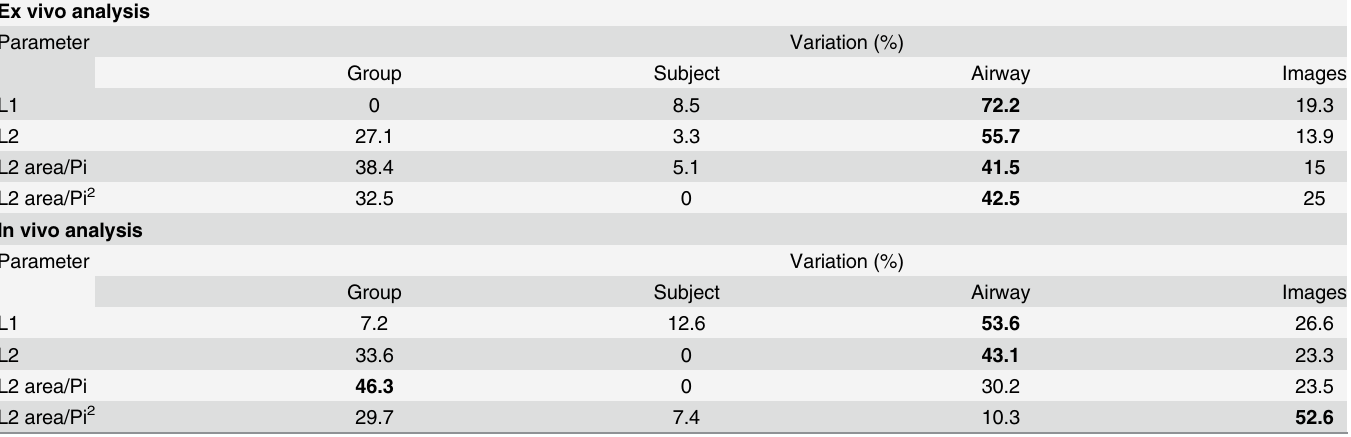
Table 4. Variance component